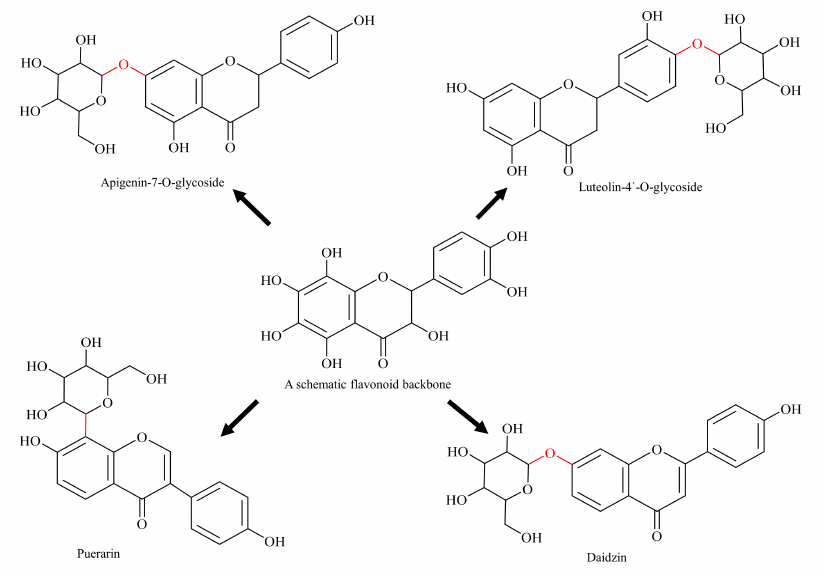
Figure 3. Diagrammatic representation of glycosylated flavonoids (schematic flavonoid is a hypo- thetical compound used to show all hydroxyl positions accessible for